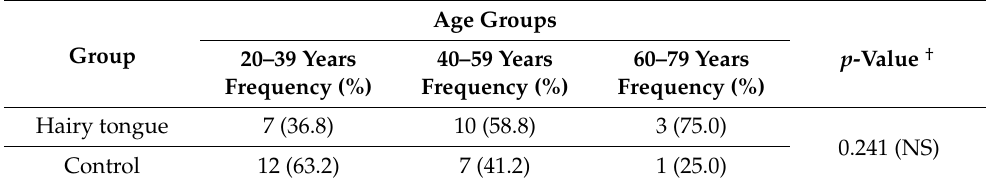
Table 3. Distribution of the hairy tongue lesions according to the age groups in the hairy tongue group and the control group with the result of significance testing.